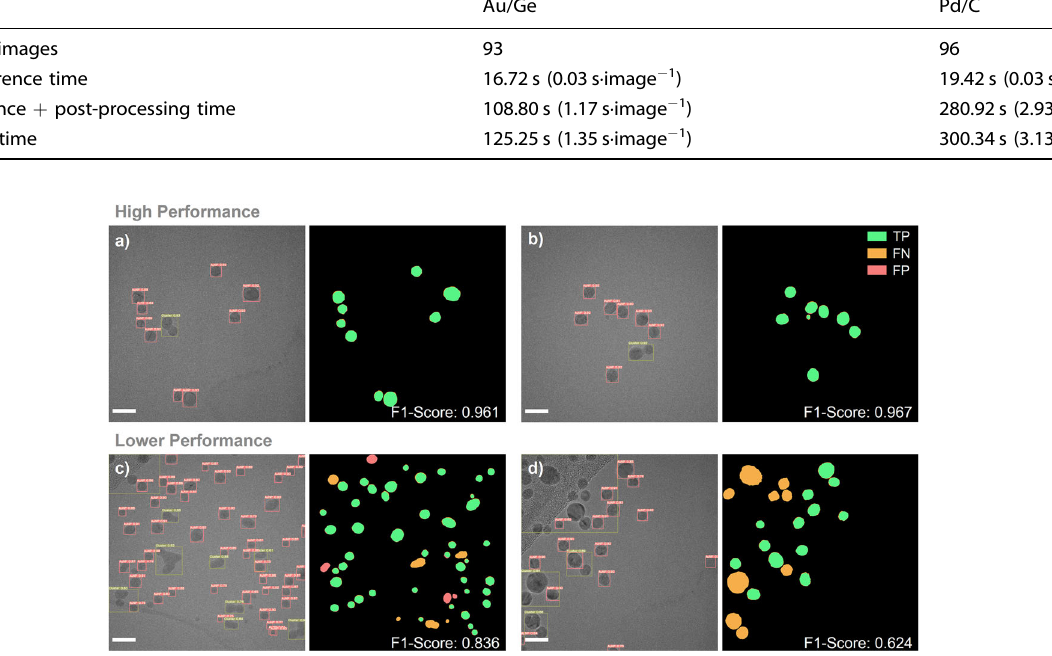
Fig. 2 Object detection with colour-coded segmentation masks for the Au/Ge system. a , b Cases of high performance. c , d Cases with lower performance. The colour legend on the right of ( b ) is used for all colour-coded segmentation masks. ‘ Nanoparticle ’ instances are labelled as ‘ AuNP ’ while ‘ cluster ’ instances are labelled as ‘ Cluster ’ in the object detection outputs. Scale bar: 20